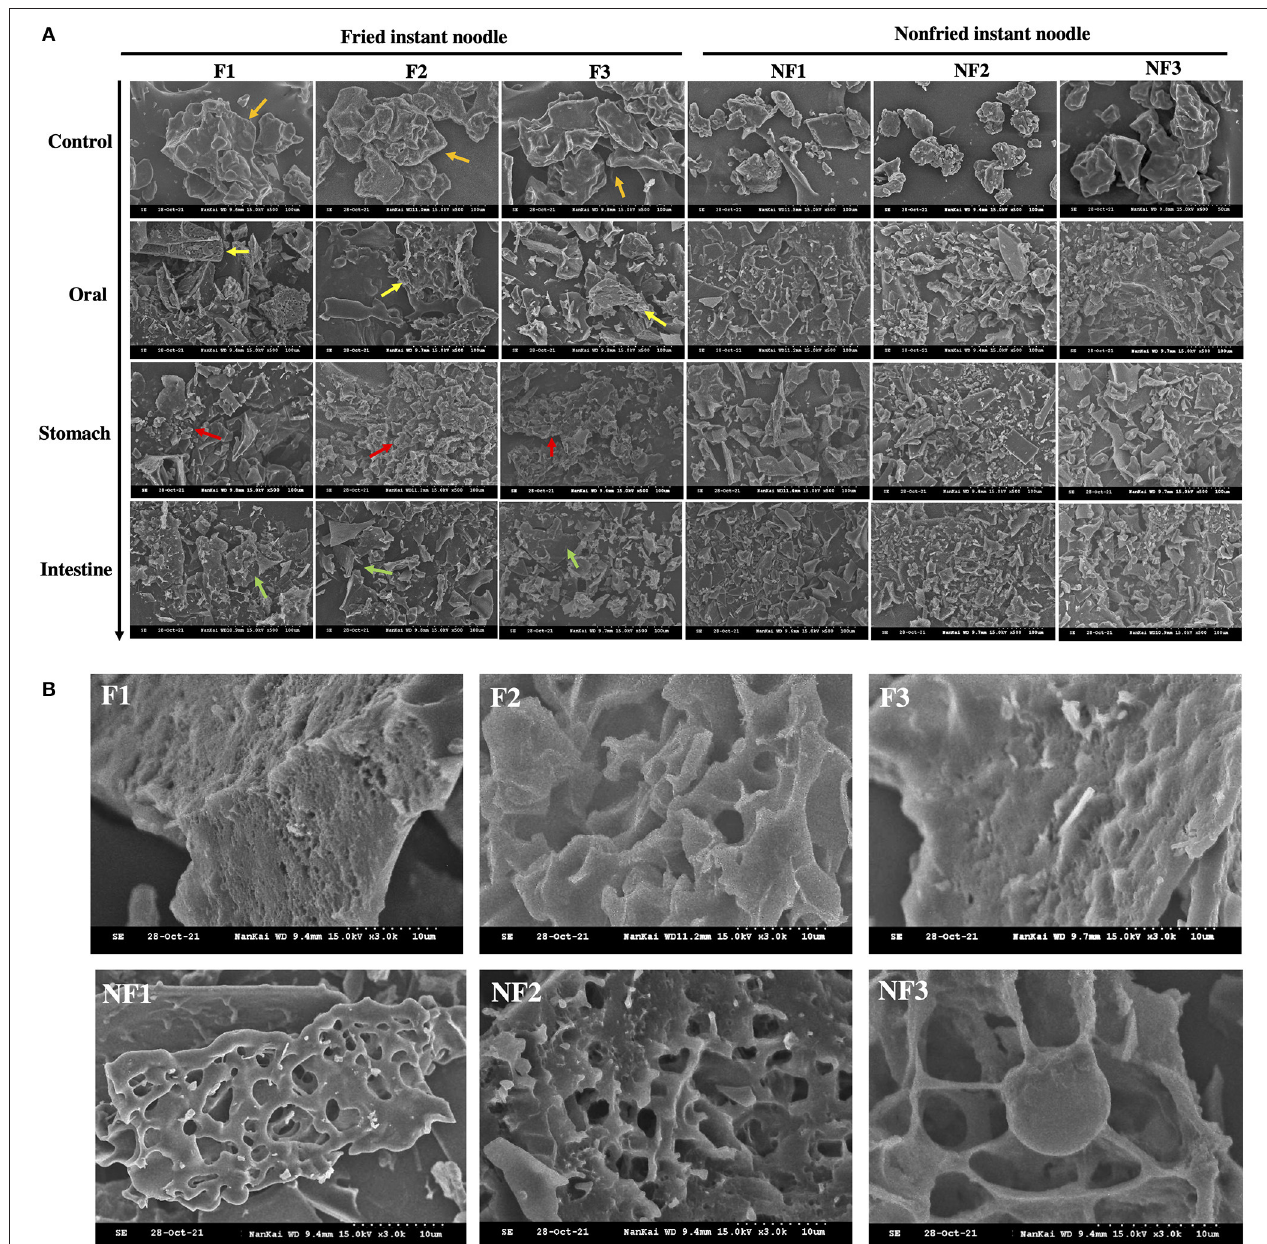
FIGURE 4 | (A) Microstructure changes of fried and non-fried instant noodle products during simulated in vitro digestion (500 × ); (B) SEM image of instant noodle products at the final phase of digestion (3000 ×